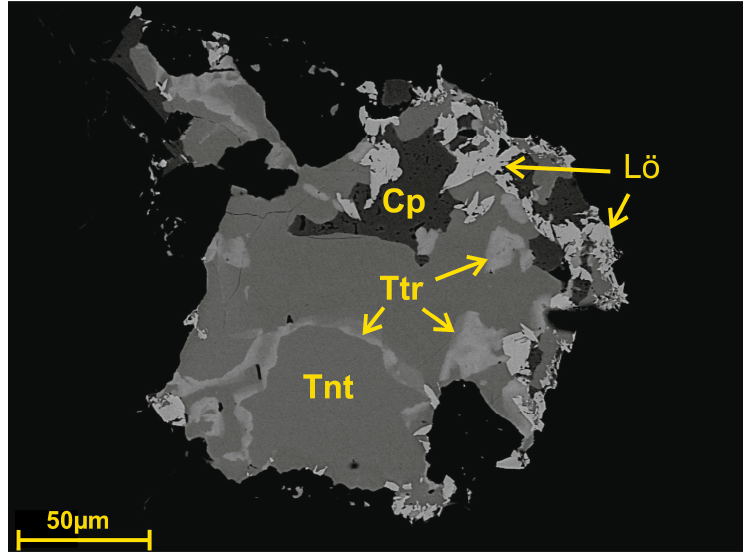
Figure 16. Aggregate of tennantite (Tnt), tetrahedrite (Ttd), chalcopyrite (Cp), and löllingite (Lö) from the Pellapahk deposit. BEI.